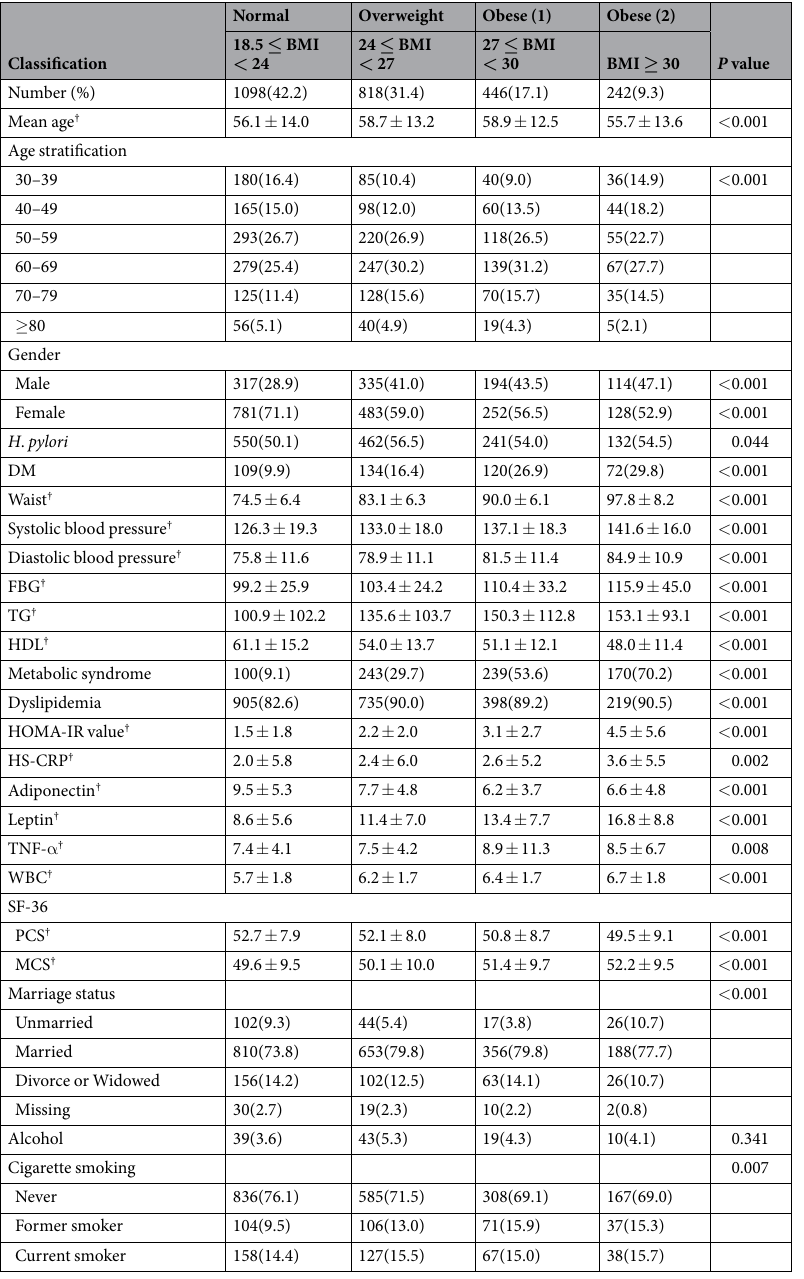
Table 1. Demography and Characteristics of Subjects by Body Mass Index Stratification. BMI = body mass index, DM = diabetic mellitus, HOMA-IR = homeostasis model assessment of insulin resistance, HS- CRP = high-sensitivity C reactive protein, TNF- α = Tumor necrosis factor alpha, WBC = white blood cell, SF-36 = short form 36, PCS = physical component summary, MCS = mental component summary, † data presented as mean ± standard